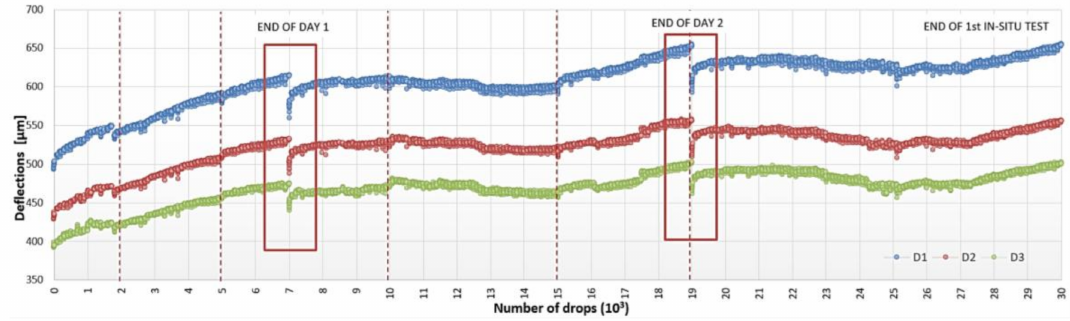
Figure 3. Deflections D1, D2, and D3 (recorded at 0, 200, and 300 mm from the load plate, respectively) evolution trend normalized to 1700